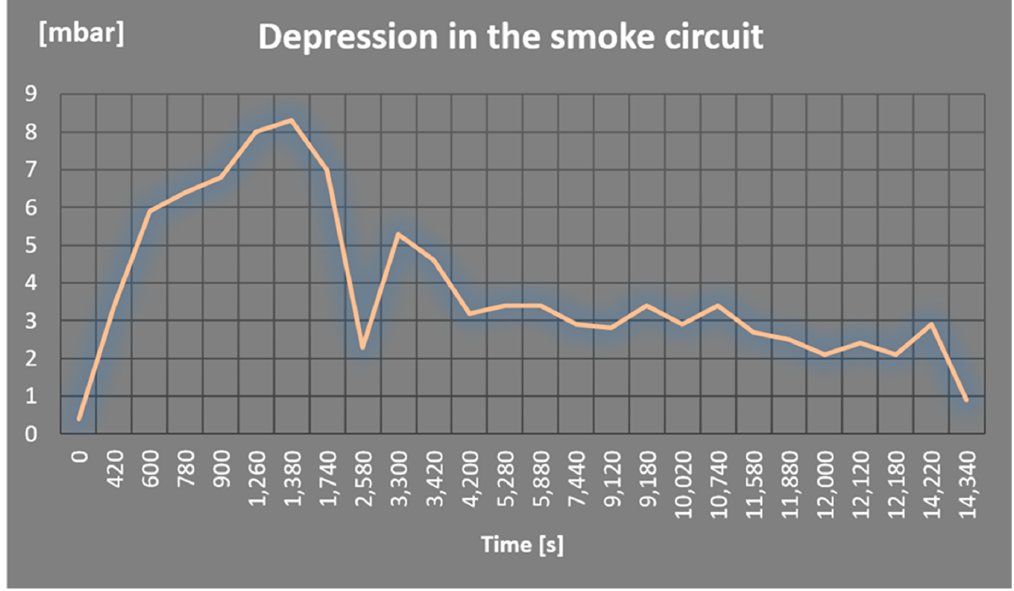
Figure 9. Trend of the depression in the smoke circuit.